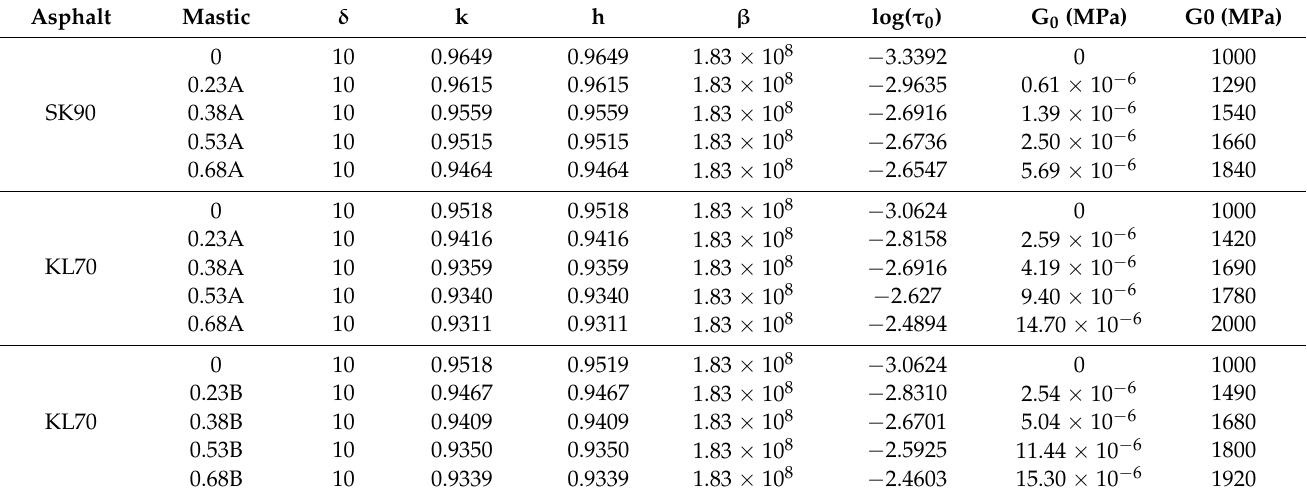
Table 3. Parameters of the 2S2P1D model for all the binders and corresponding mastics.